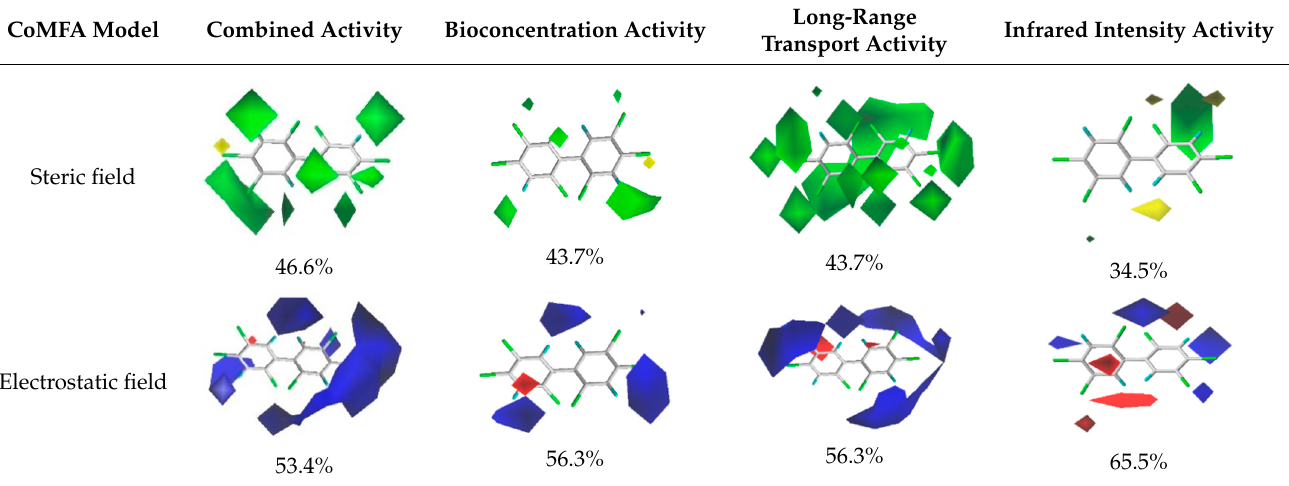
Table 4. The single activity and combined activity contour maps of PBBs bioconcentration, long-range transport, and the highest infrared signal intensity.